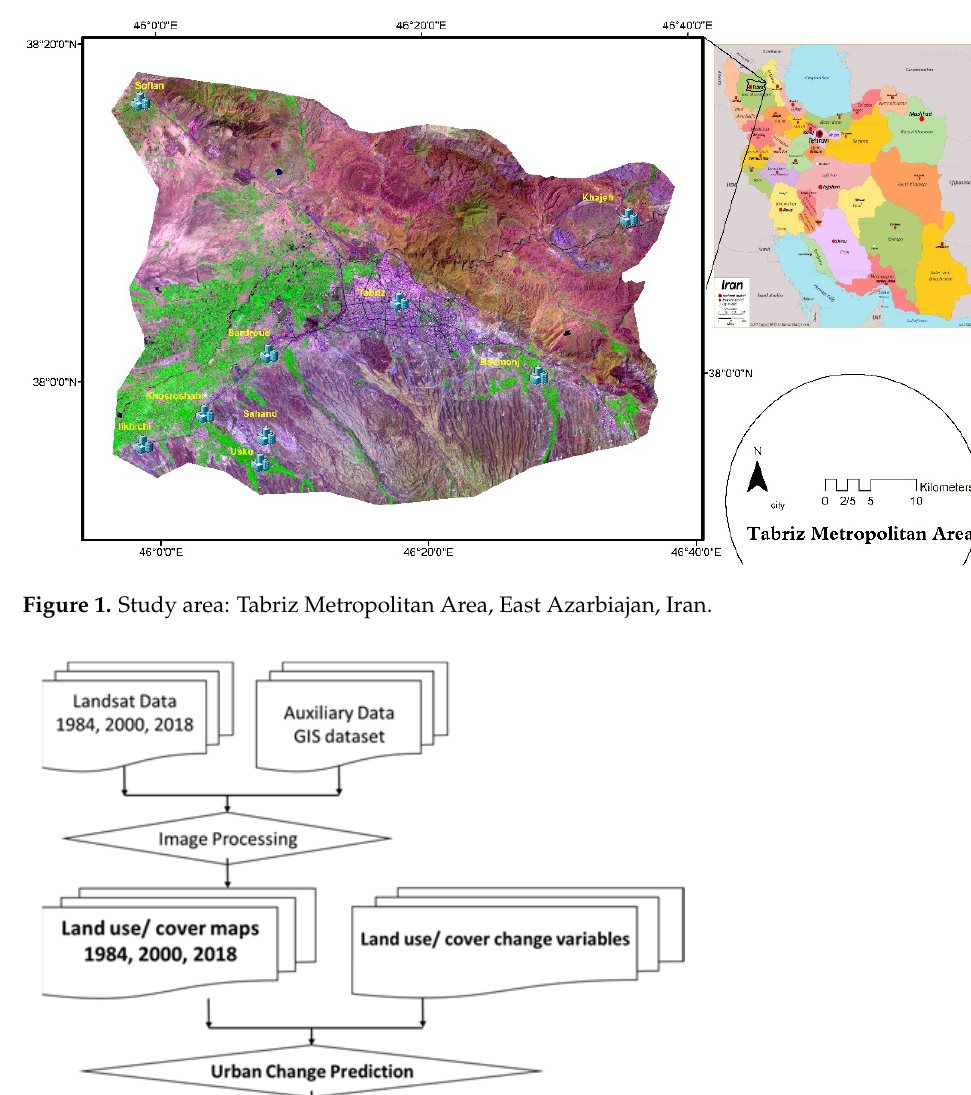
Table 1. Characteristics of remote sensing data.